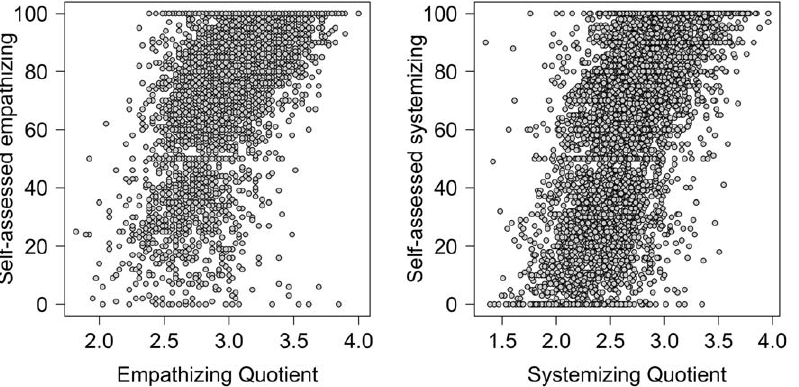
Figure 5. Scatter plots comparing people’s self-assessed ratings of empathizing and systemizing with their scores on the EQ and SQ. Empathizing scores are shown in the left panel, systemizing scores in the right panel.